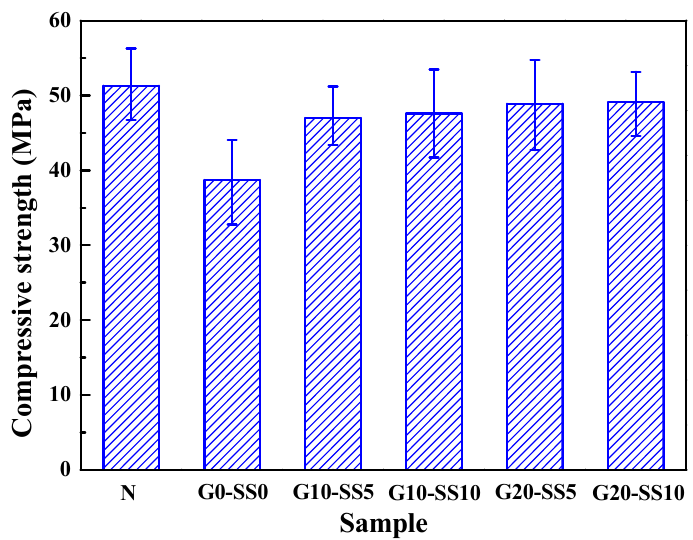
Figure 12. The compressive strengths of the concrete samples.